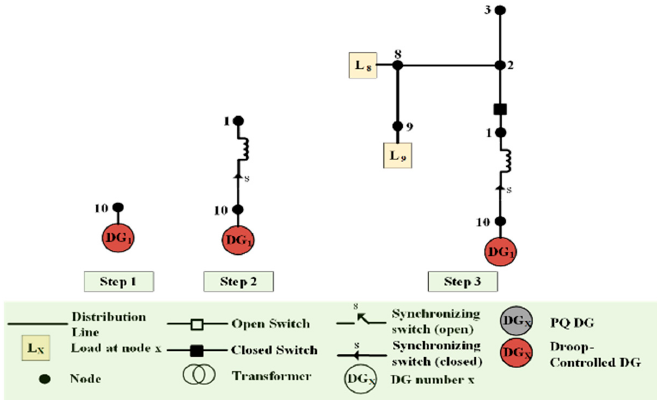
Figure 4. Step 1, 2, and 3 of an Example Restoration Process.